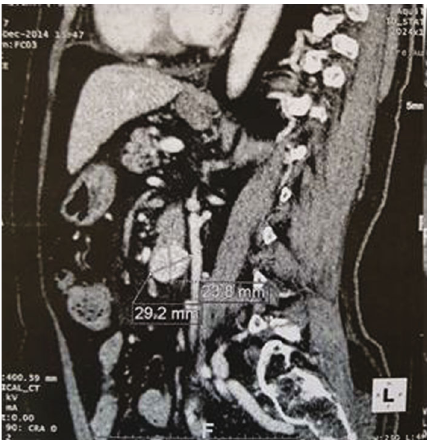
Figure 1: CT aspect of the tumor.